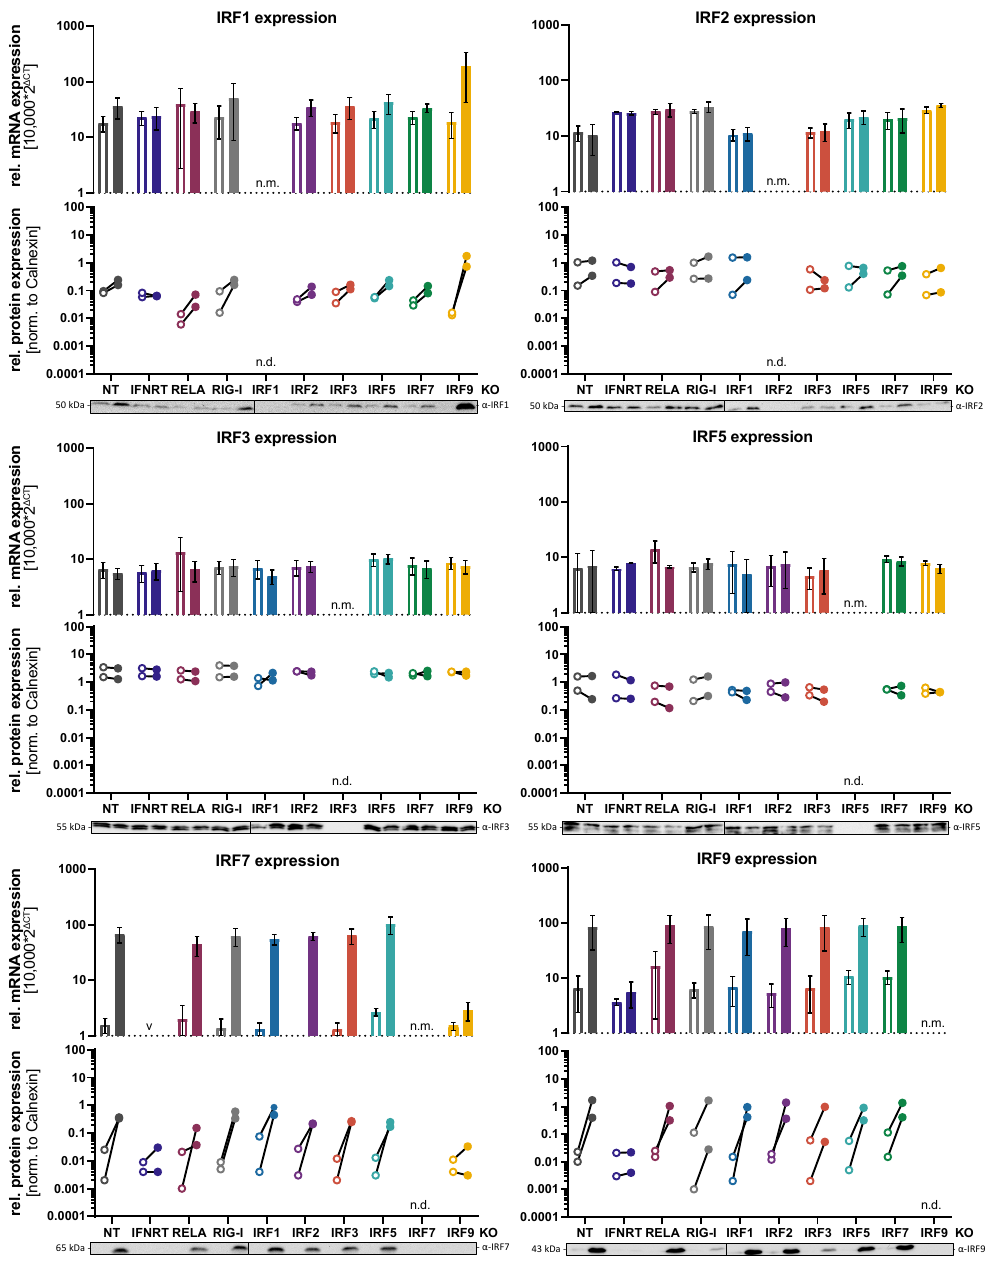
Figure 1. Baseline and IFN stimulated expression of IRFs and their mutual dependence on other IRFs. A549 NT (non- targeting CRISPR control), A549 IFNR TKO (IFNAR1, IFNGR1, IFNLR triple KO), A549 RELA KO (RELA/NF- κ B p65 KO), A549 RIG-I KO (RIG-I KO), and A549 IRF (as indicated) KO were mock treated (empty bars and symbols) or treated with IFN- α (200 IU/mL) for 16 h (solid bars and symbols). The expression of IRF1, -2, -3, -5, -7, and -9 was determined at mRNA level by qRT-PCR (relative to GAPDH, top half of panels), mean ± SD of three independent experiments is shown. IRF expression at the protein level was determined by immunoblotting (lower half of panels). For protein quantification, immunoblot ECL signals were measured by a CCD instrument and normalized to the respective signal of the loading control (calnexin). Quantifications of two independent experiments are shown and one of the two experiments is shown as an image at the bottom; see also Supplementary Figure S1. Protein and mRNA levels of the respective knocked-out IRFs were not determined